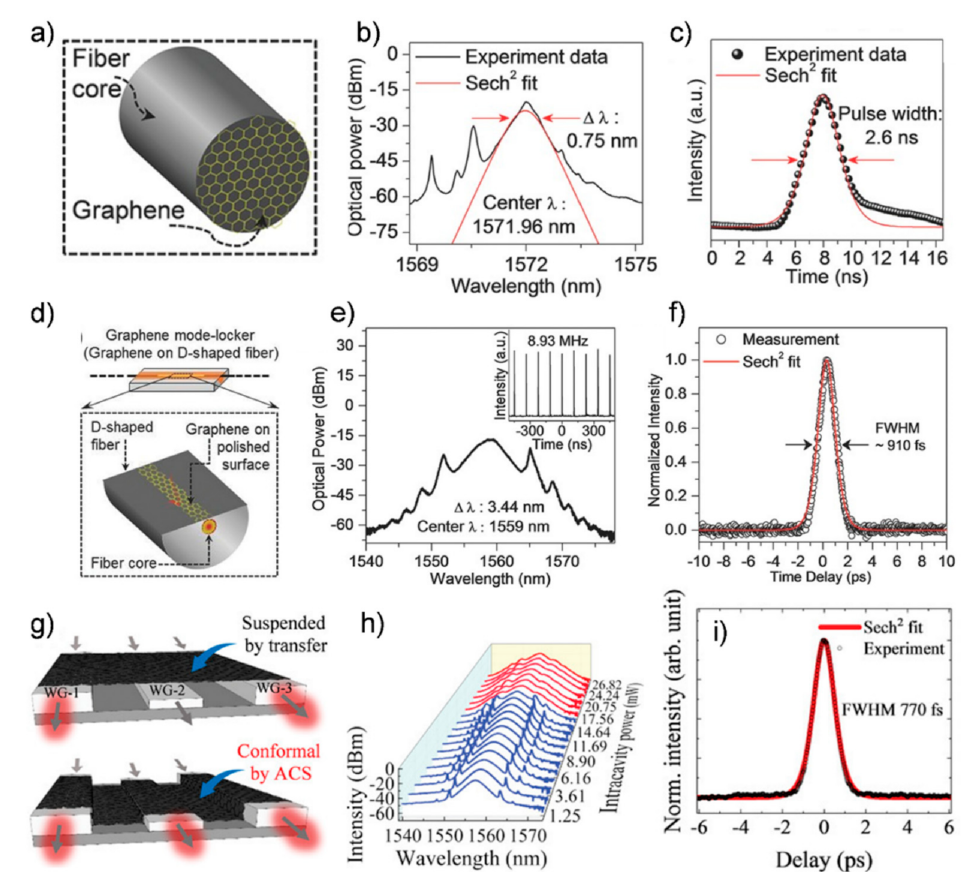
Figure 7. ( a ) Schematics of the mode-locker device made from in-situ grown graphene on SMF end facet; ( b ) Output characteristics of pulse spectrum in wavelength domain mode-locked with device shown in ( a ); ( c ) Pulse duration with the mode-locker device shown in ( a ); ( d ) Schematics of mode-locker device made from in-situ grown graphene on the flat face of a D-shaped fiber; ( e ) Output characteristics of pulse spectrum in wavelength domain mode-locked with device shown in ( d ); ( f Pulse duration with mode-locker device shown in ( d ); ( g ) Superiority of ACS-grown graphene over transferred graphene; ( h ) Intracavity power dependent optical spectra of the pulses; ( d ) Duration of the mode-locked pulses. ( a – f ) Reproduced with permission from [82]. Copyright WILEY-VCH